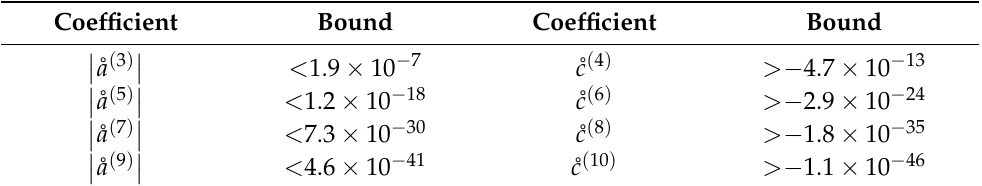
Table 2. Estimated bounds on isotropic oscillation-free coefficients from a threshold analysis of IceCube data. Units are GeV 4 − d . Reprinted with permission from [91]. Copyright 2011 by The American Physical